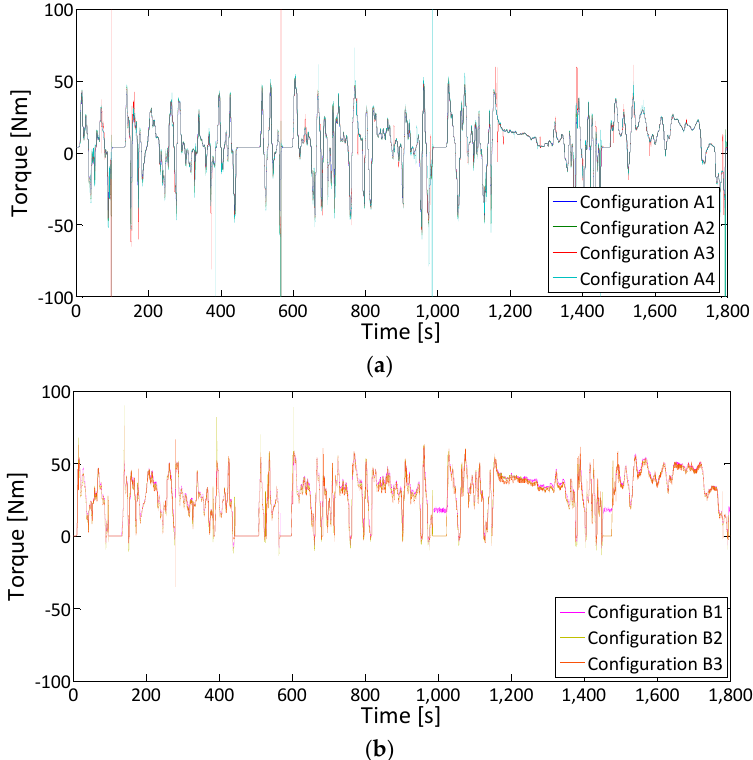
Figure 12. ( a ) Battery output power under Configurations A1–A4; ( b ) Battery output power under Configurations B1–B3. Energies 2018 , 11 , x